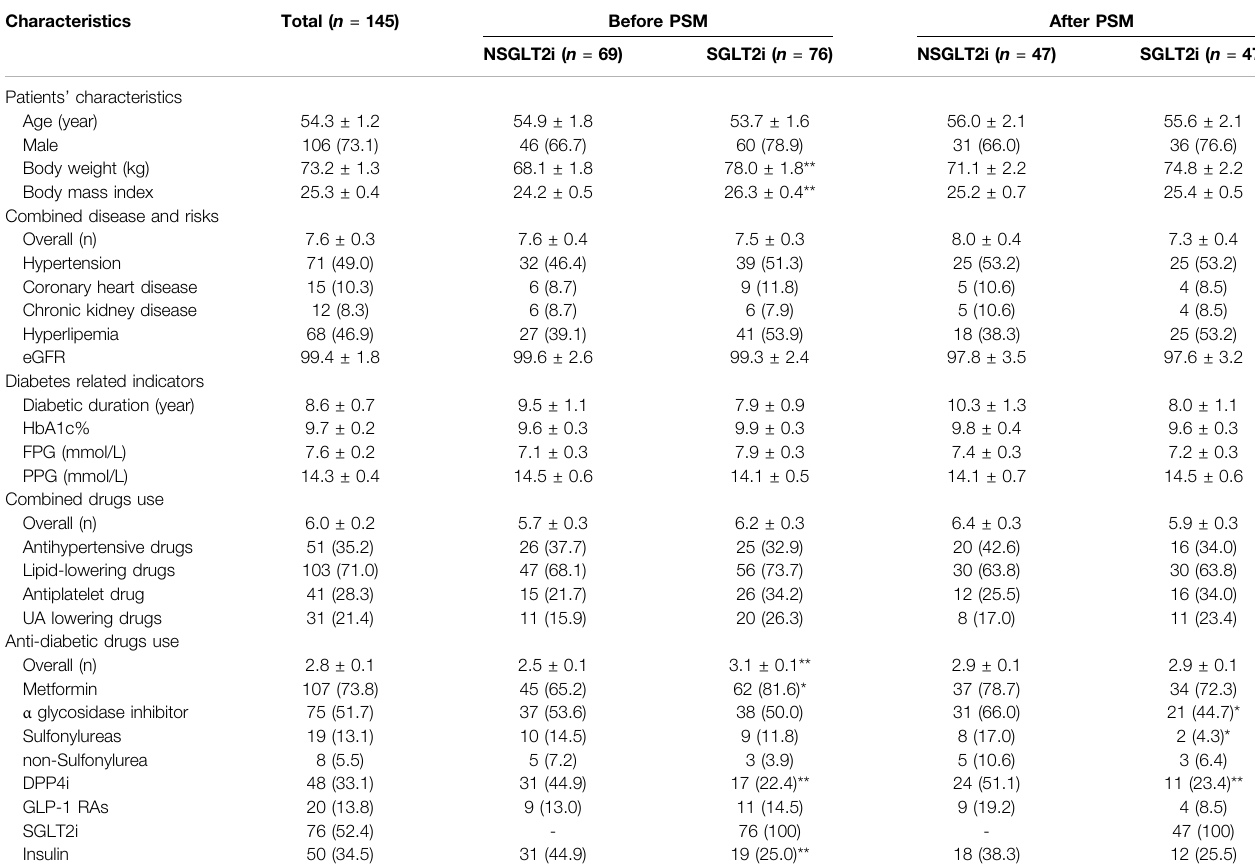
TABLE 2 | Demographics and characteristics of patients. Characteristics